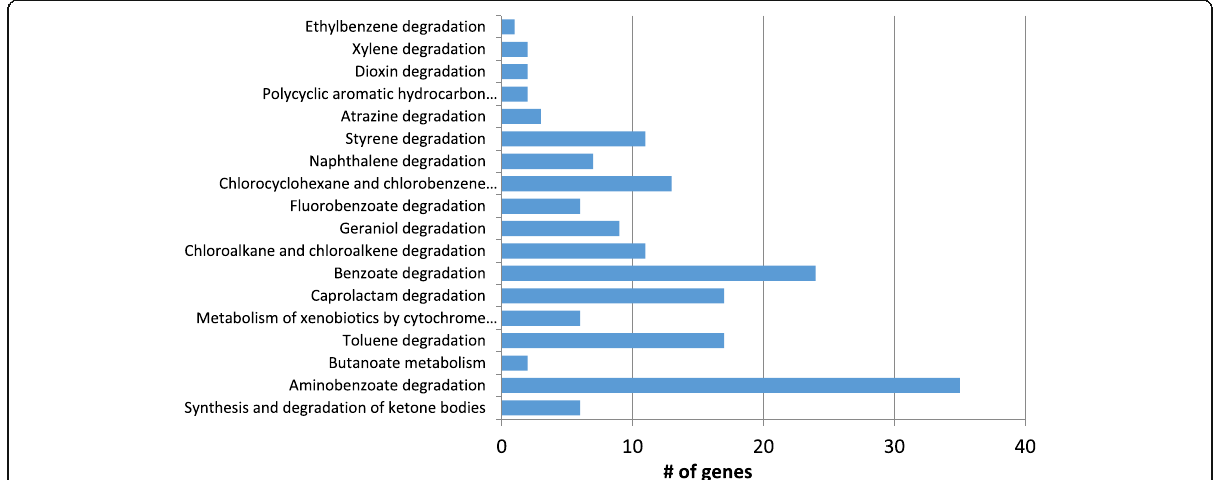
Fig. 3 Distribution of the hydrocarbon degradation genes in KEEG pathways. The bars represent the number of genes mapped in KEEG pathways related to hydrocarbon degradation. Most of the genes were mapped to the benzoate and its derivate compounds as aminobenzoate and